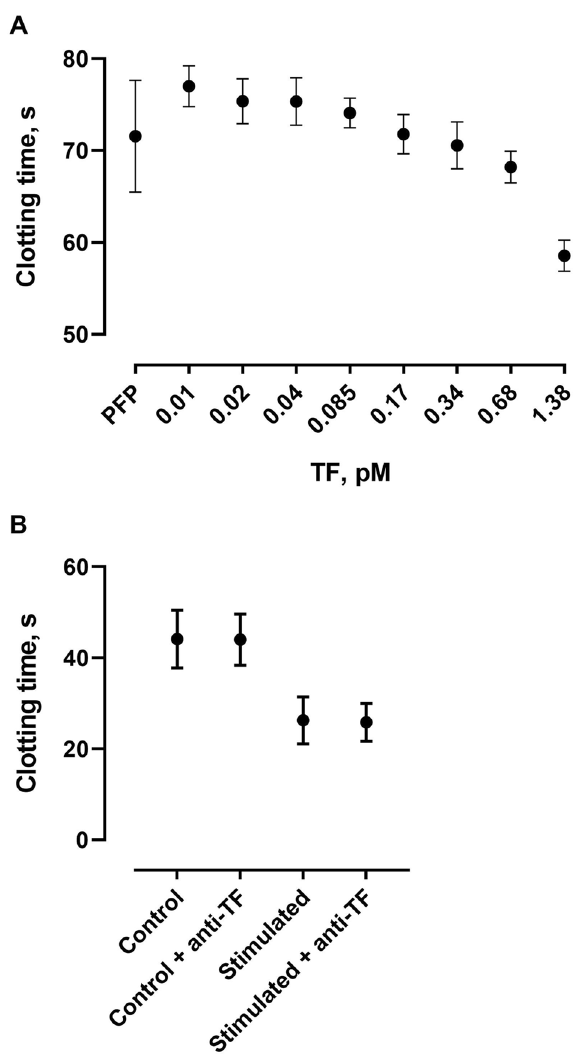
Figure 7. The effect of TF on the modified PPL assay. Exogenous relipidated TF was added to the modified PPL assay in concentrations from 0.01 to 5.5 pM (panel A ). Panel ( B ) illustrates the effects of EVs from LPS-PMA stimulated blood and inhibitory TF antibody on clotting times in the PPL assay. Values are means ± 1 SD (panel A , B ) from three